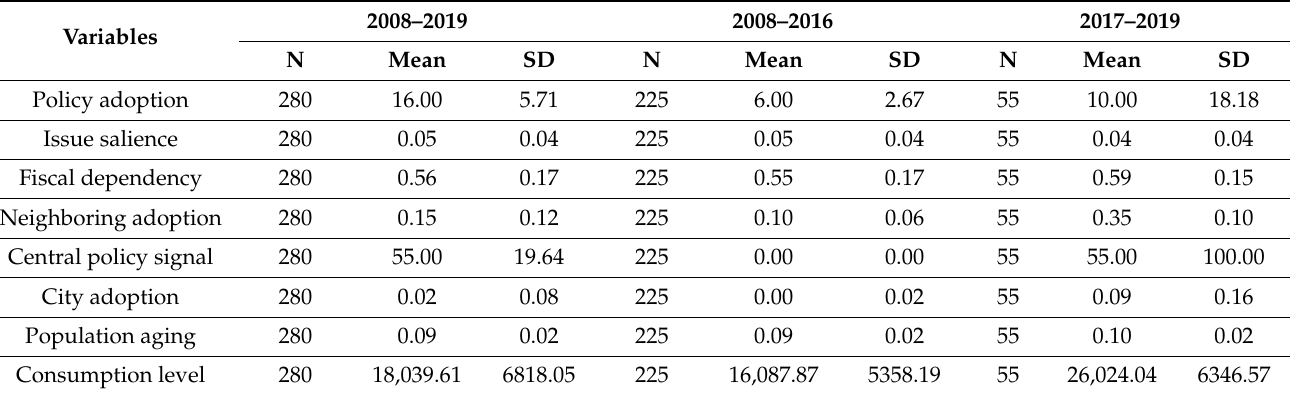
Table 2. Descriptive statistics of